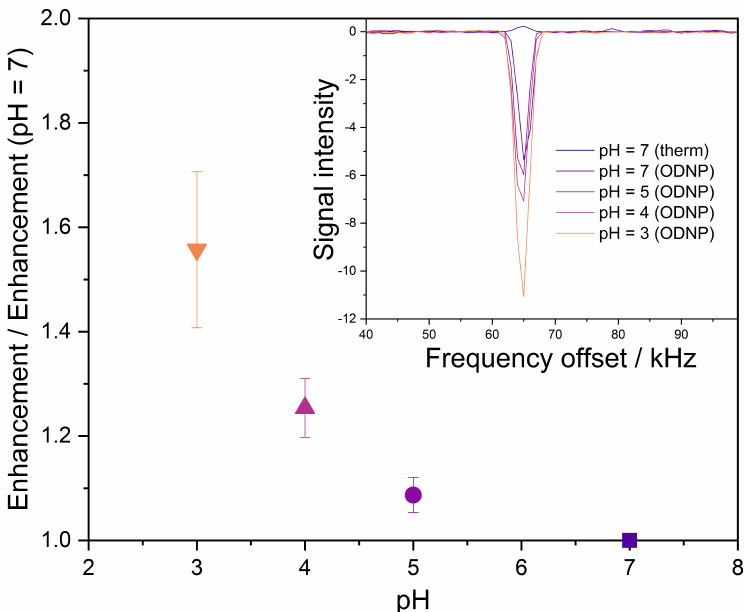
Figure 4. Results from static ODNP-enhanced 1 H NMR measurements of water with CPG-PEI25000- GT (pore size 200 nm) at different pH. The symbols are experimental results and were obtained as the arithmetic mean of five individual samples. The error bars indicate the standard deviation. Insert: thermally polarized (therm, acquired with 16 scans) and hyperpolarized (ODNP, single-scan) 1 H NMR